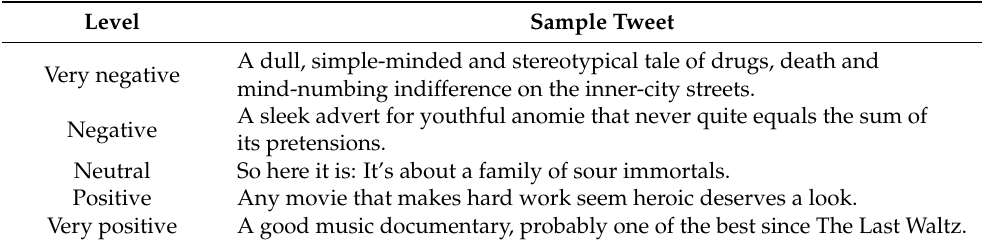
Table 2. Sample tweets representing different sentiment levels based on the pretrained model. These samples were from the corpus provided by the Stanford CoreNLP toolkit [49]. Level Sample Tweet A dull, simple-minded and stereotypical tale of drugs, death and Very negative mind-numbing indifference on the inner-city